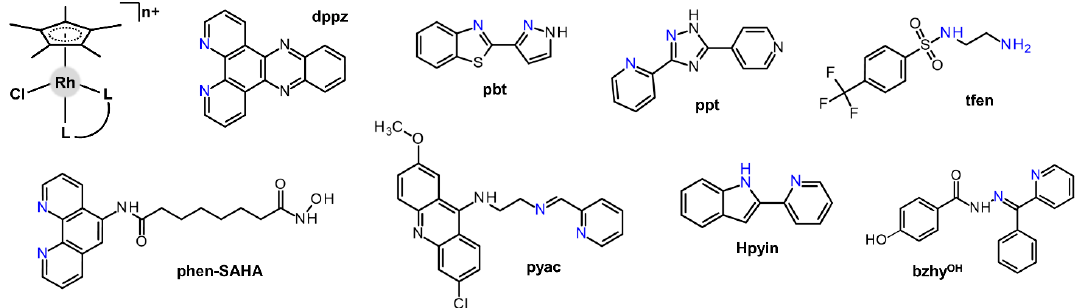
Figure 3. The general structural formula of the [Rh( η 5 -Cp*)(L^L)Cl] n+ complexes and structural formulas of selected bidentate N , N -donor L^L ligands, with donor nitrogen atoms given in blue.